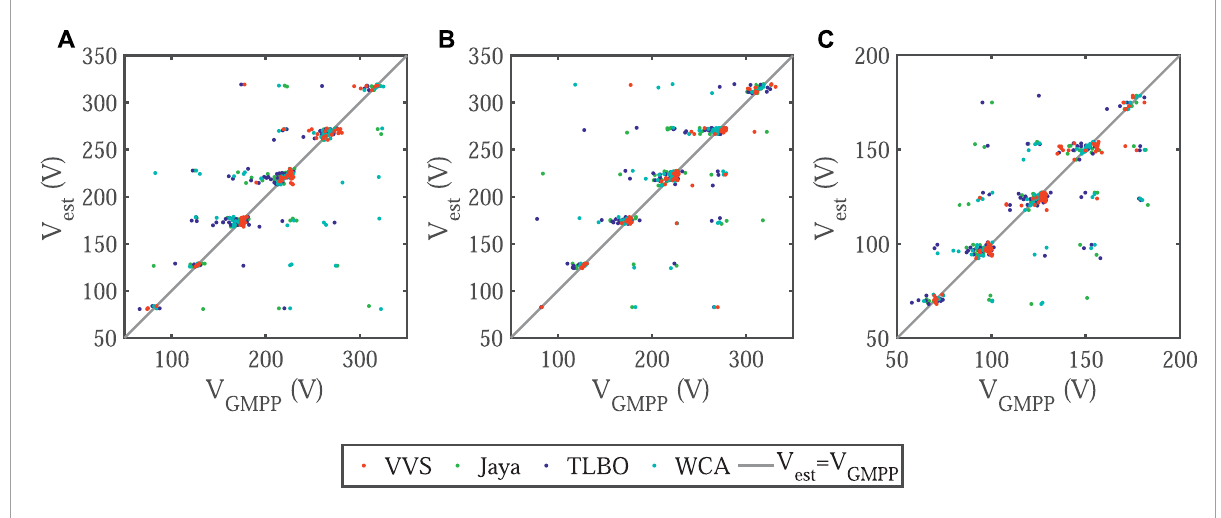
FIGURE 5 V GMPP and V est distribution of the VVS, Jaya, TLBO, and WCA: (A) HIT-N225A01 PV string; (B) KC175GT PV string; (C) JH-10 PV string.